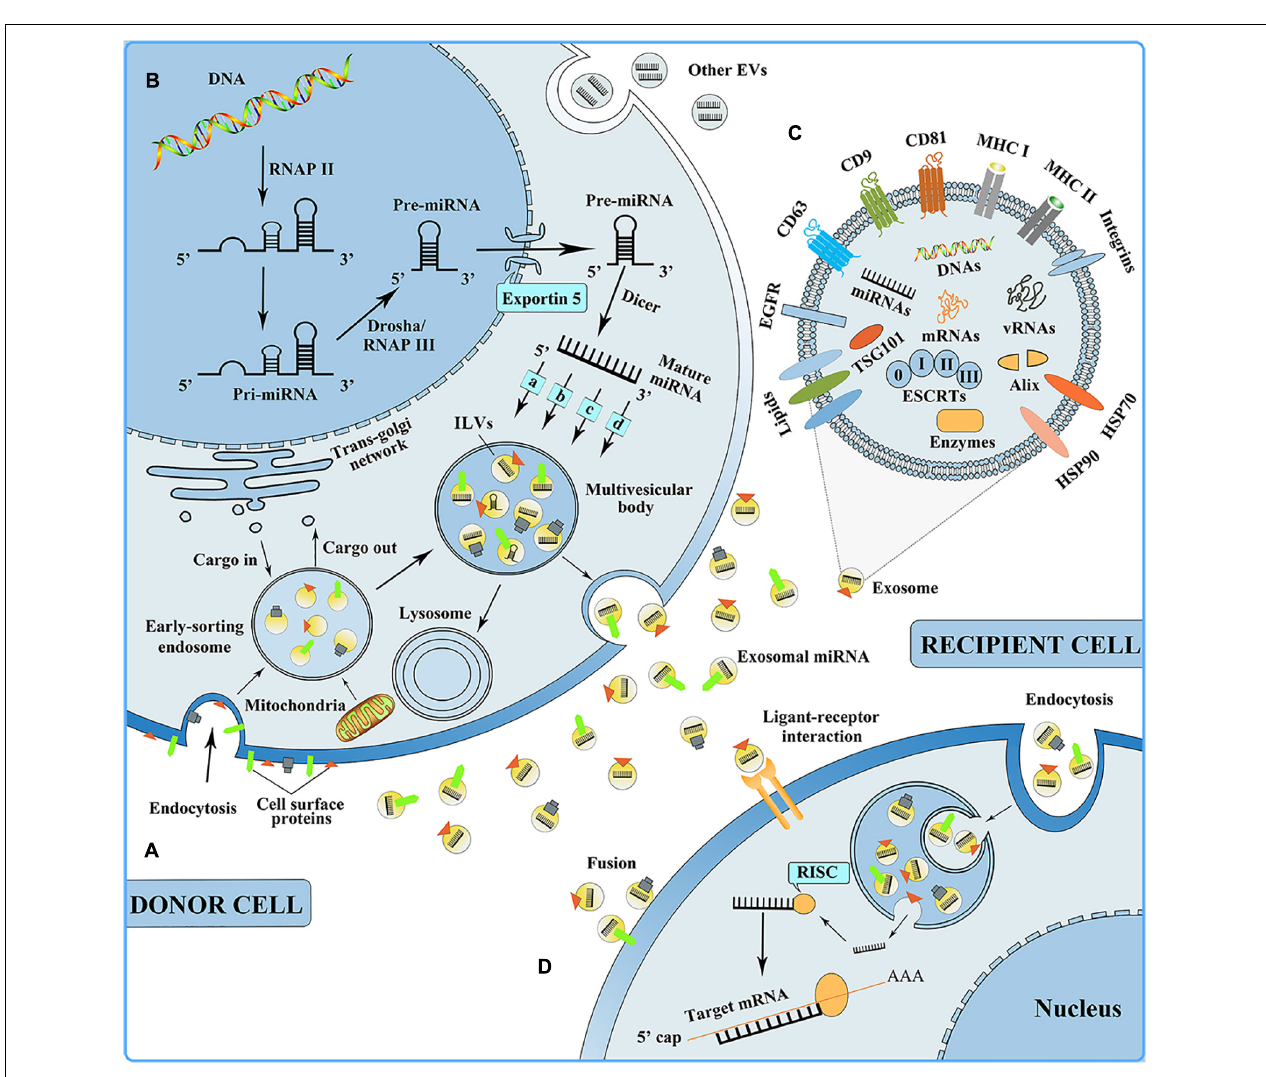
FIGURE 2 | (A) Exosome biogenesis. EVs, extracellular vesicles. (B) miRNA biogenesis, sorting into exosome, and mediating intercellular communication. RNAP II, RNA polymerase II; RNAP III, RNA polymerase III; (a) nSMase2-dependent pathway; (b) the miRISC-related pathway; (c) 3 (cid:48) miRNA sequence-dependent pathway; (d) miRNA motif and sumoylated hnRNPs-dependent pathway. RISC, RNA-induced silencing complex. (C) Exosome composition. ESCRTs, endosomal-sorting complex essential for the transport, including ESCRT 0, ESCRT I, ESCRT II, and ESCRT III; EGFR, epidermal growth factor receptor; HSP, heat shock protein. (D) Exosomes can be taken up by the recipient cell in three ways: Endocytosis, ligand-receptor interaction, and fusion.